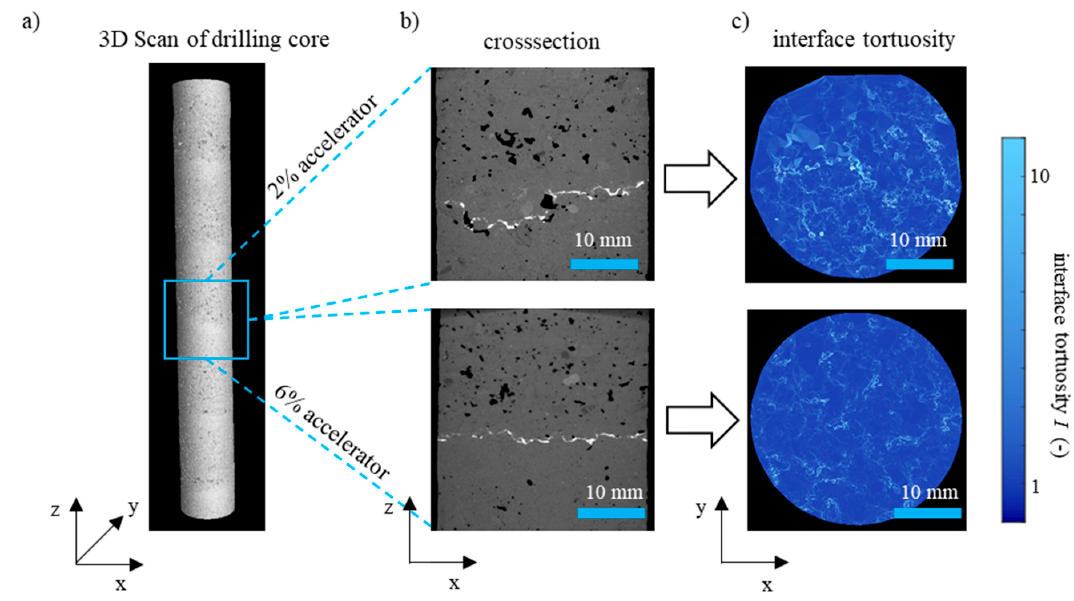
Figure 5. Method to investigate the interlayer exemplified for two experiments with various content in accelerator: ( a ) 3D scan of a drilling core, ( b ) interlayer between strand three and four (white line) and ( c ) calculation of the interface tortuosity.